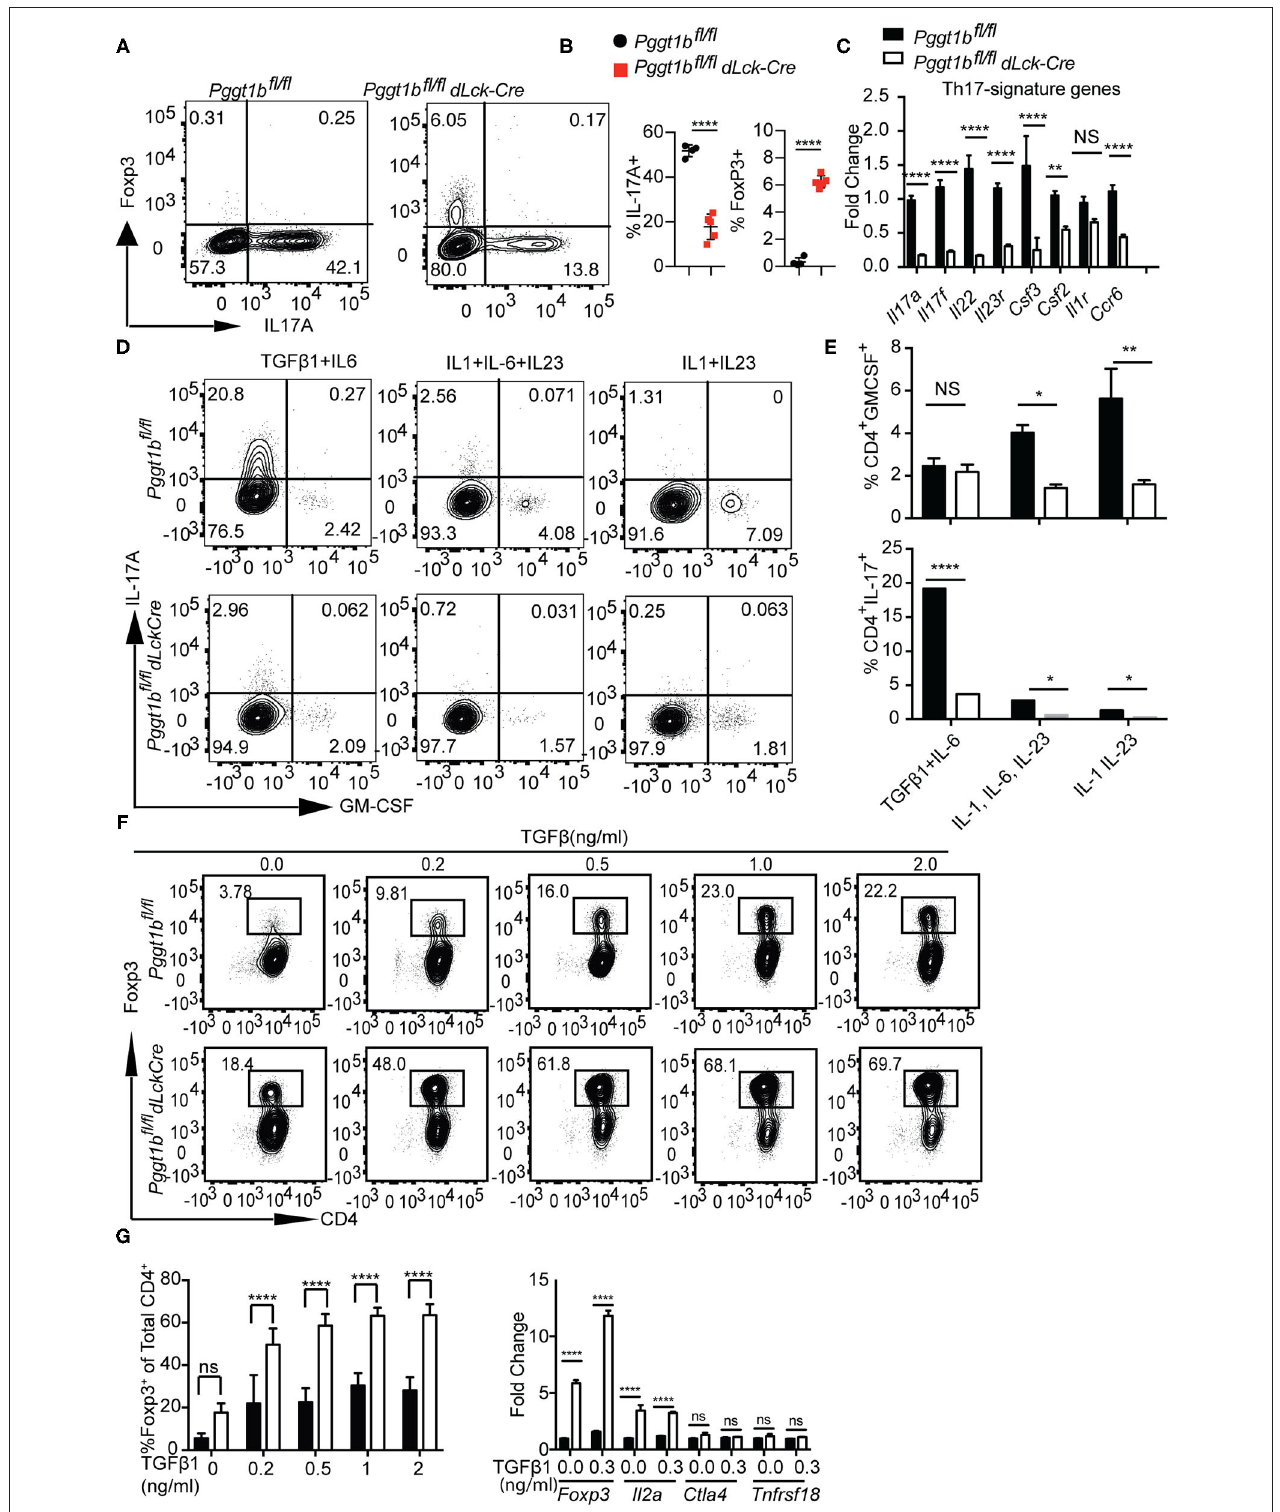
FIGURE 7 | Pggt1b-deficient naive T cells are predisposed to differentiate into T regulatory cells in vitro . (A) Flow cytometry analysis of the expression of Foxp3 and IL-17A in cells cultured in the presence of plate-bound anti-CD3 and anti-CD28 antibodies and TGF β 1 and IL-6 for 72h; (B) Percentage of IL-17A + or Foxp3 + CD4 + cells in the culture described in (A) ; (C) Fold change of Th17 signature cytokines in cells described in (A) analyzed by qRT-PCR; (D) Flow cytometry analysis of